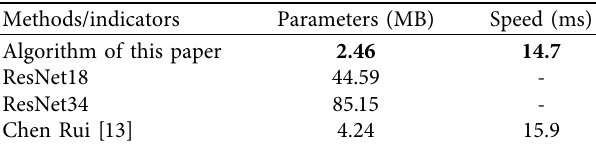
Figure 7: Test error graph of key points of each algorithm. Table 3: Parameters and speed of each